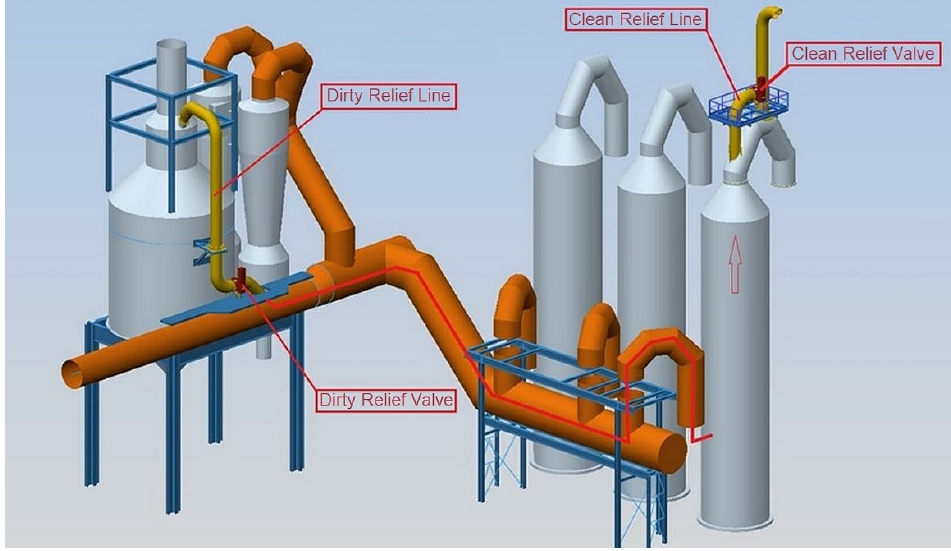
Figure 17. Scheme of the optimal solution.